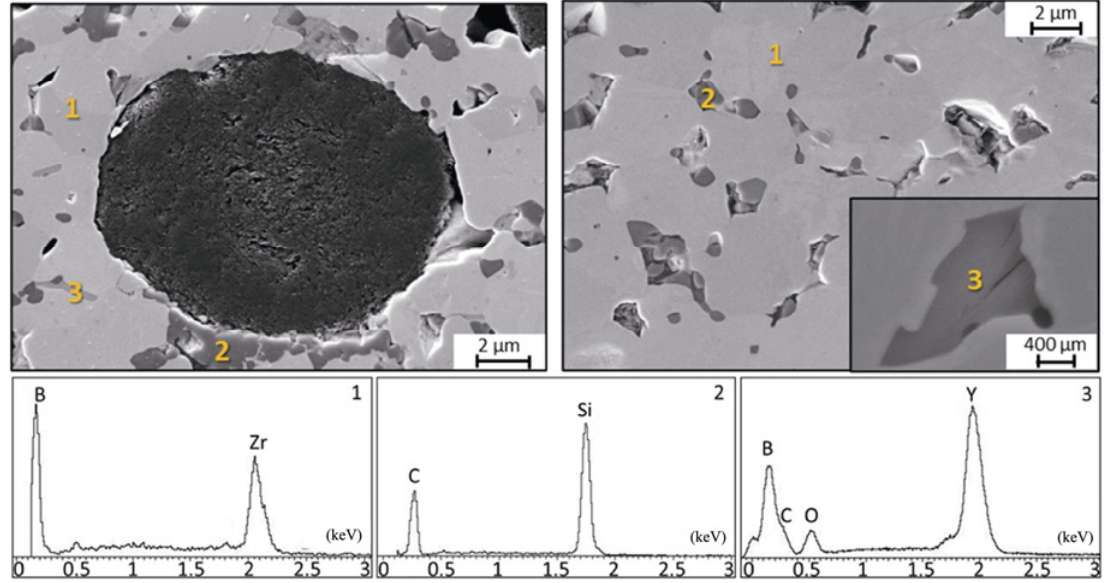
Fig. 6 High-magnification SEM images of UHTC matrix showing Y–B–C–O phases with energy dispersive spectroscopy (EDS) collected at 5 keV. Light grey and black phases are ZrB 2 and SiC, respectively, the white particles are ZrC, and the dark grey phases are Y–B–C–O